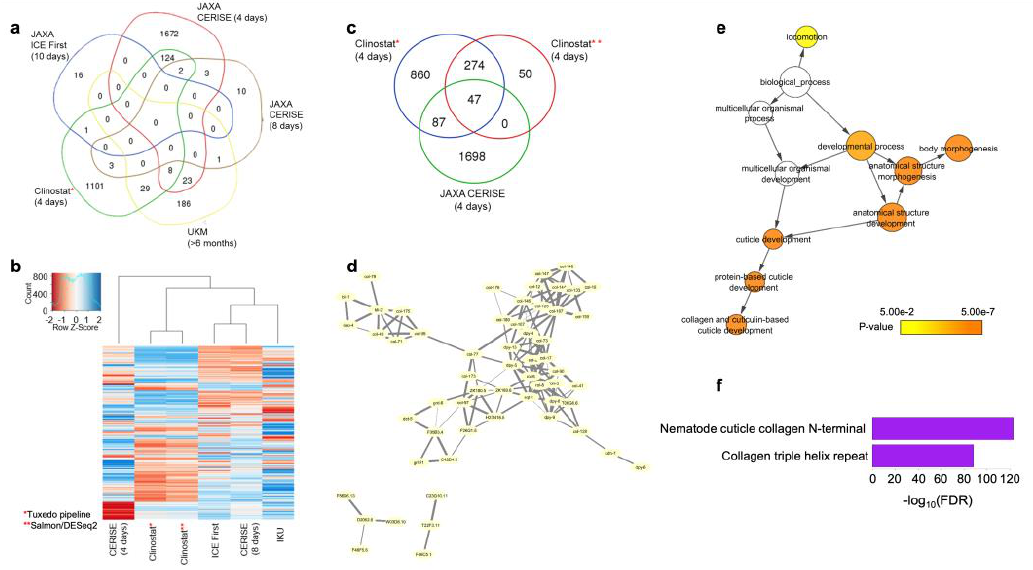
Figure 5. Microgravity-responsive genes are consistently differentially expressed in the ISS and under simulated microgravity. ( a ) Shared DEGs among the space-flown worms and our simulated microgravity experiment. The highest number of common DEGs are between our experiment and four-day CERISE. These genes are named as the “microgravity-responsive genes”. ( b ) The hierarchical clustering of the overall gene expressions among the space-flown worms and our simulated microgravity experiment. Our results analyzed with two different data analysis pipelines (*,**) demonstrated highly similar patterns. ( c ) The number of common DEGs were high for our results analyzed with two different pipelines (*,**). Both of the pipelines showed that the common number of DEGs are higher than the values expected by chance (hypergeometric text, p < 0.05). ( d ) Protein–protein interaction of the microgravity-responsive genes from STRING database. ( e ) Gene ontology enrichment of the microgravity-responsive genes. ( f ) Protein domain enrichment of the microgravity-responsive genes.